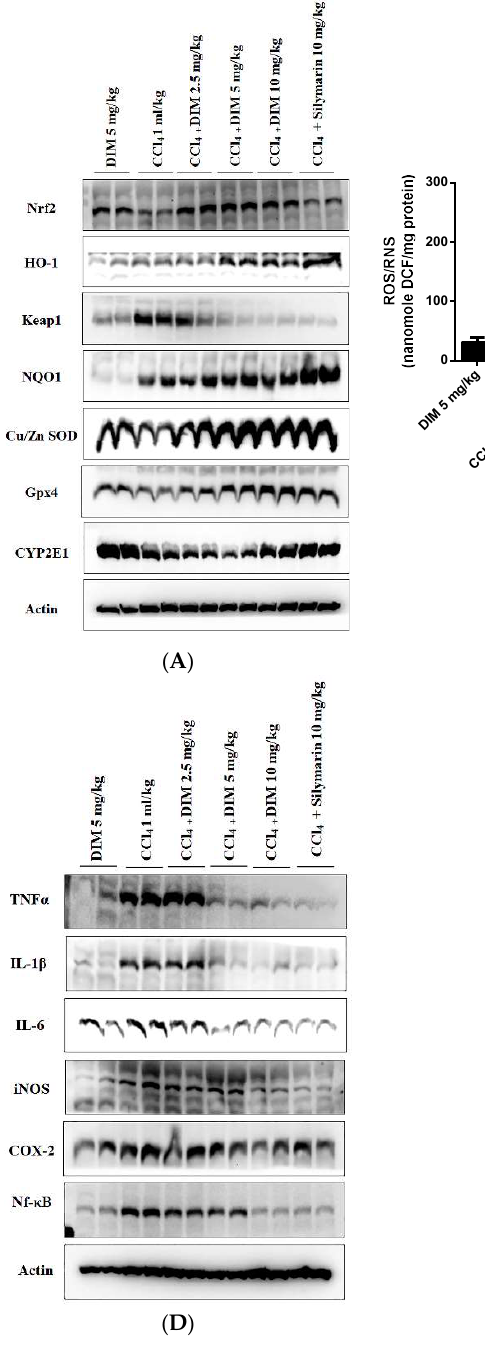
Figure 9. DIM activates hepatic Nrf2 and attenuates CCl 4 -induced ROS, oxidative stress, and inflammatory cytokines in mouse liver fibrosis. ( A ) Expression levels of Nrf2 and antioxidative proteins in liver tissues were determined by Western blotting. ( B ) Effects of DIM on the production of ROS by calculating relative fluorescence unit (RFU)/µg protein. ( C ) Analysis of CCl 4 -induced lipid peroxidation by measuring MDA levels using a commercial kit. ( D ) Anti-inflammatory effects of DIM on the expression of inflammatory cytokines by Western blotting. All data are presented as mean ± SD ( n = 7). ### p < 0.001 denotes significant differences compared to the group treated with DIM only; ** p < 0.01 and *** p < 0.001 denote significant difference compared to the CCl 4 group.